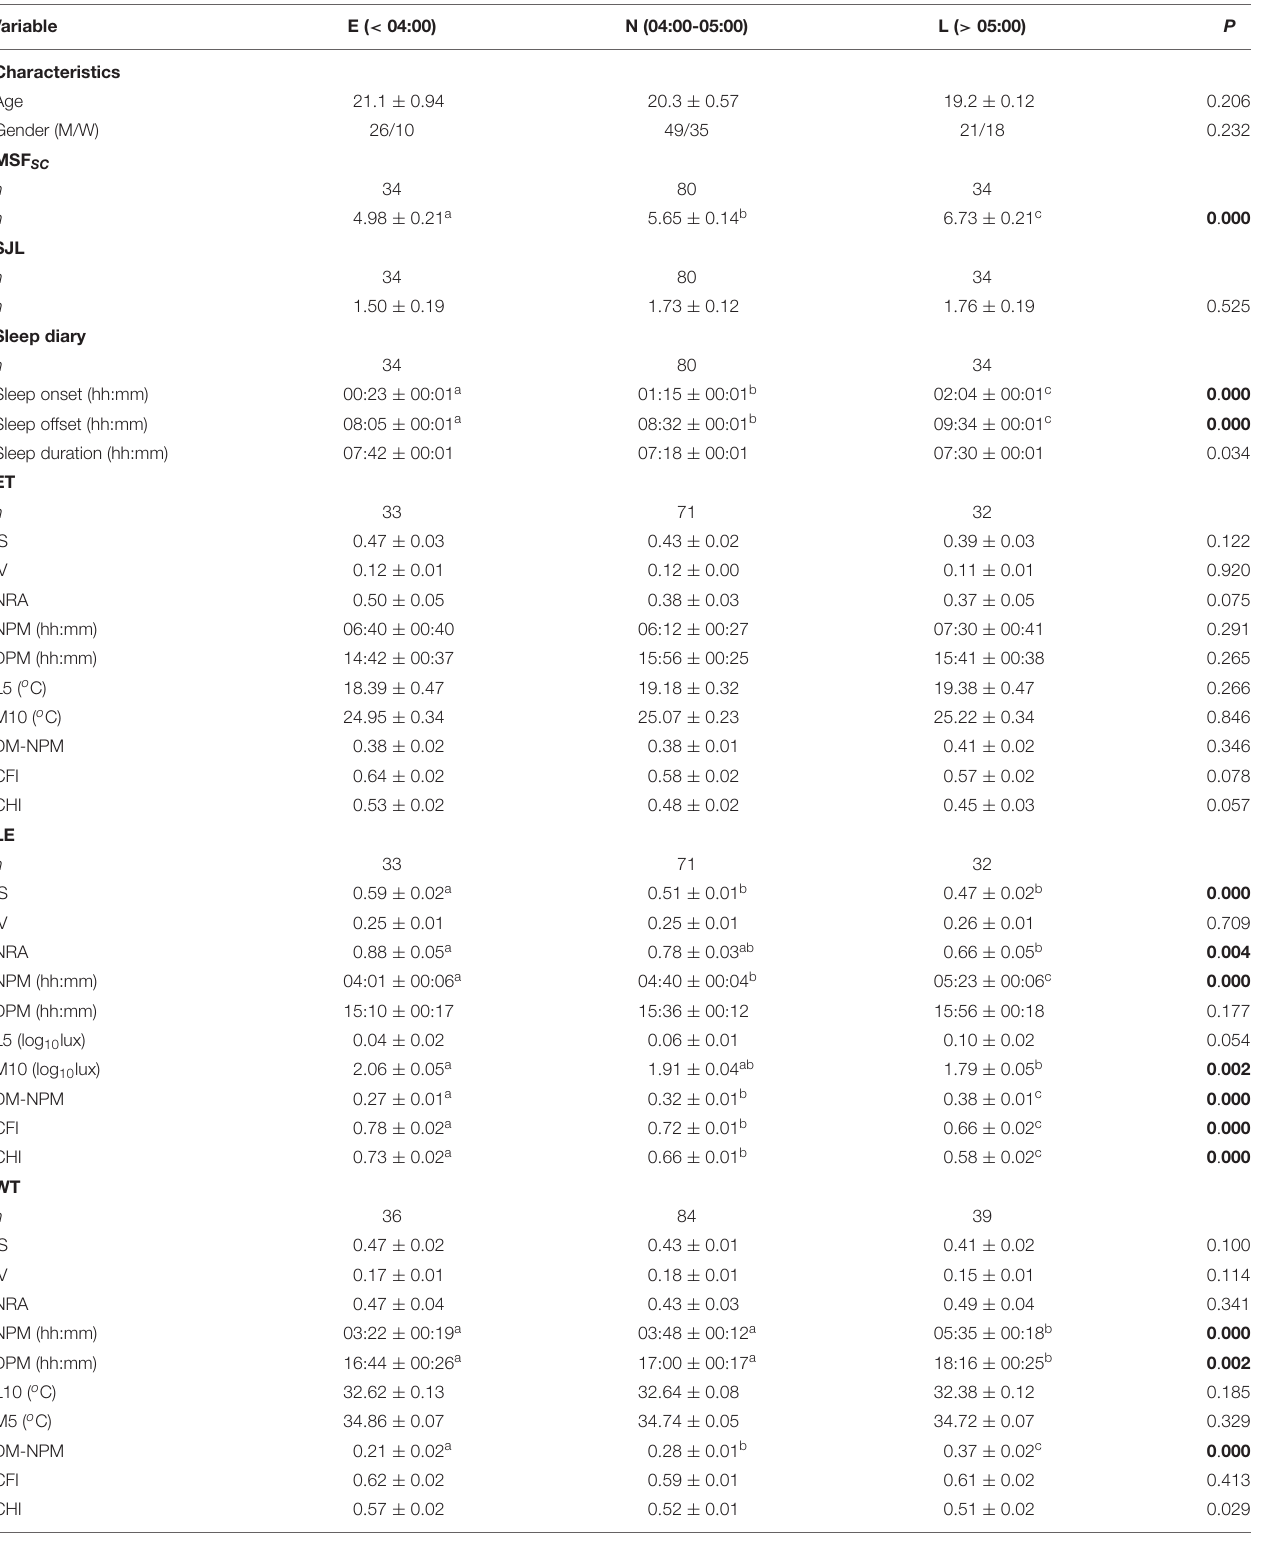
TABLE 2 | MSFsc, midsleep on free days corrected for sleep deficit, and non-parametrical indexes of the circadian rhythms (light exposure, environmental temperature, wrist temperature, activity, body position, integrated variable TAP, and sleep) according to chronotype.